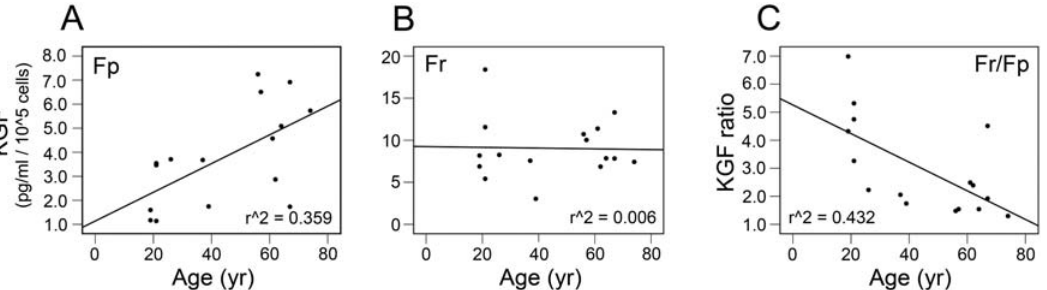
Figure 3. Secretion of KGF by Fp and Fr as a function of donor’s age. Evolution of secretion was estimated by linear regression in a cohort of 16 different pairs of Fp and Fr obtained from independent donors, ranging from 19 to 74 years old. Secretion of KGF was quantified. Values are